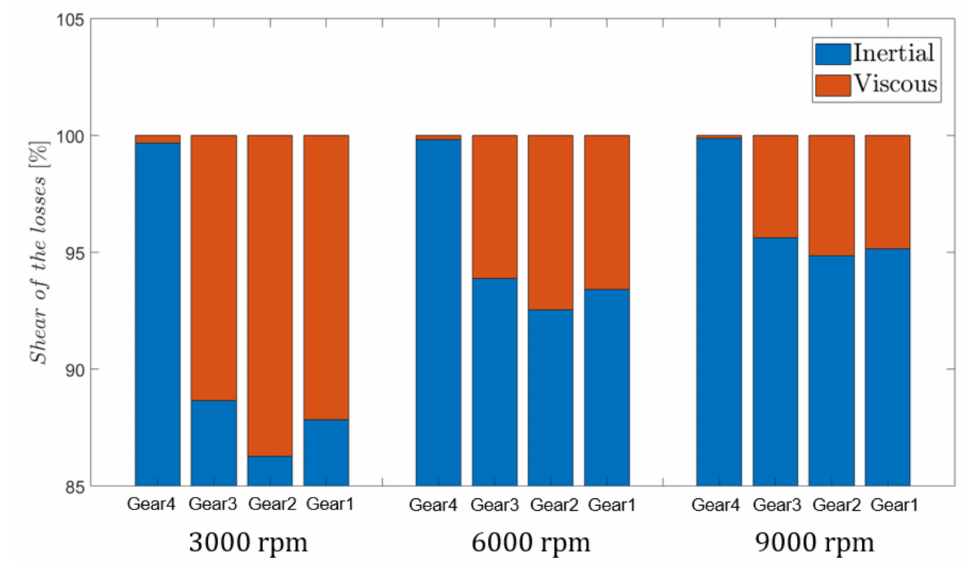
Figure 11. Percentage share of the inertial and viscous contribution for each gear at the analyzed rotational speeds.